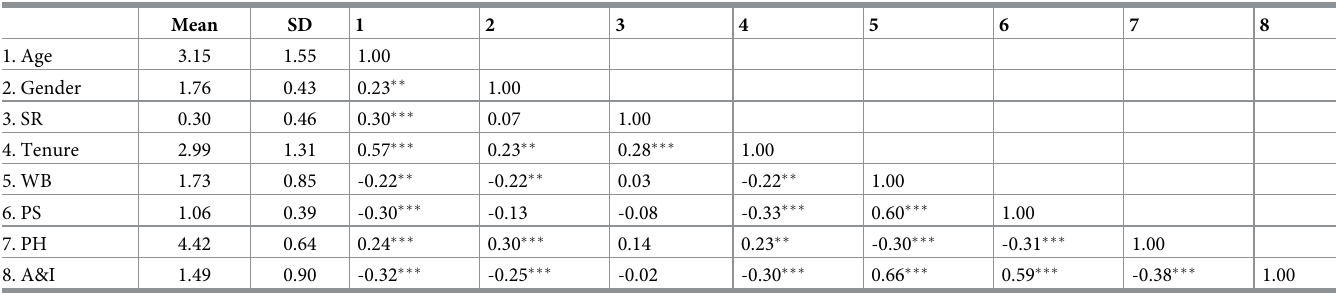
Table 4. Descriptive statistics and inter-correlations in Study